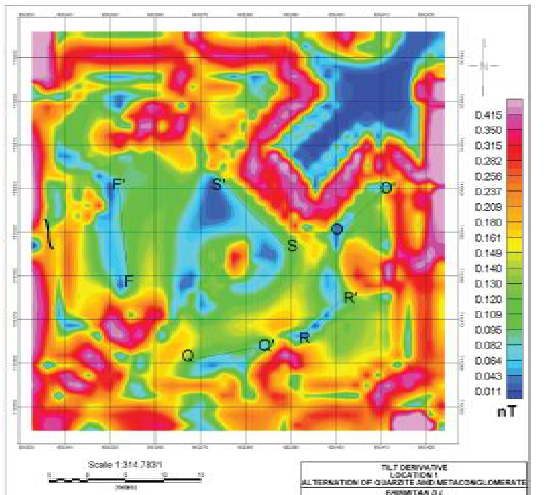
Figure 7: Upward continuation of location 1 traverse 1-3